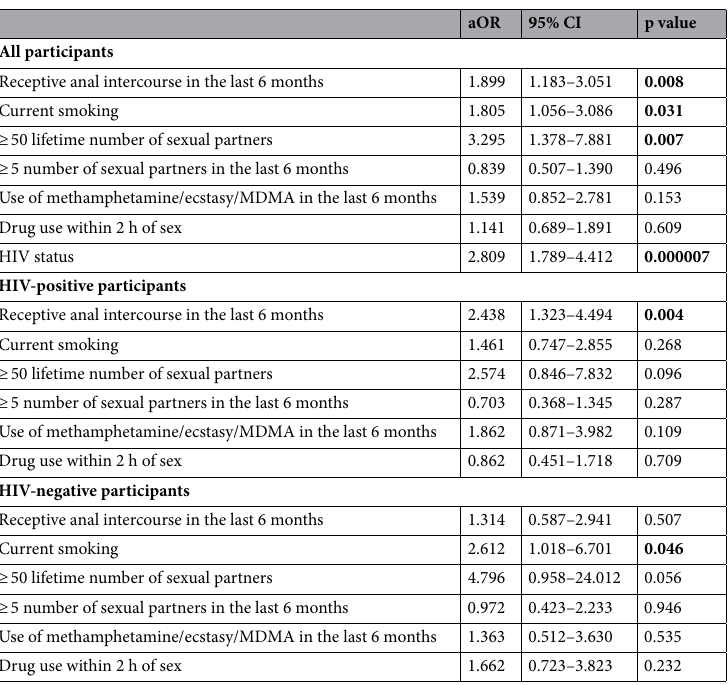
Table 4. Multivariable analysis of risk factors for anal infection with multiple HPV genotypes. aOR adjusted odds ratio, CI confidence interval, Hosmer–Lemeshow goodness-of-fit statistics, p = 0.878. P value of < 0.05 was determined as statistically significant